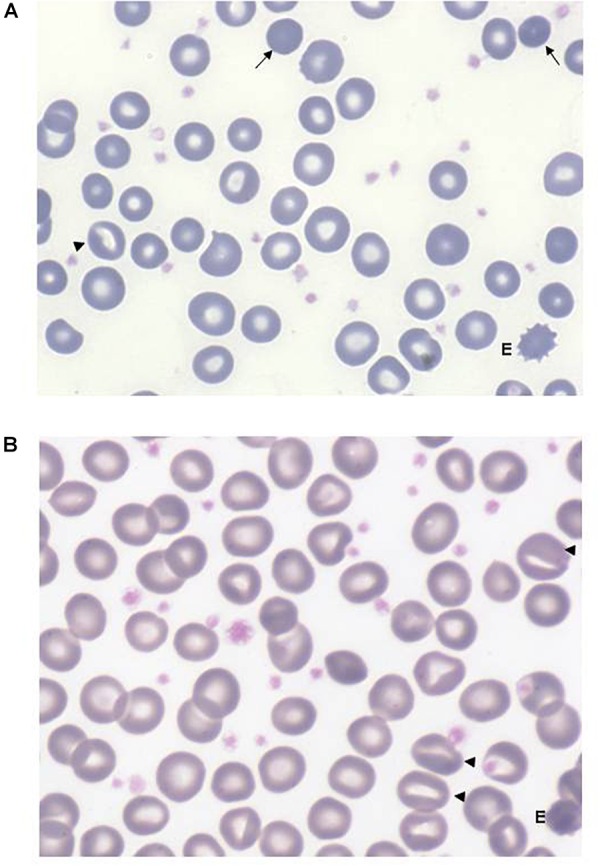
Peripheral red cell morphology from a non-splenectomized (A) and from a splenectomized (B) GPI patient (May-Grünwald’s Giemsa staining). Anisopoikilocytosis with presence of rare spherocytes (arrows), stomatocytes (triangles), more evident after splenectomy, rare echinocytes (E). The increased platelet number in panel (B) is due to splenectomy, some large and vacuolated platelets are likely due to EDTA anticoagulant.